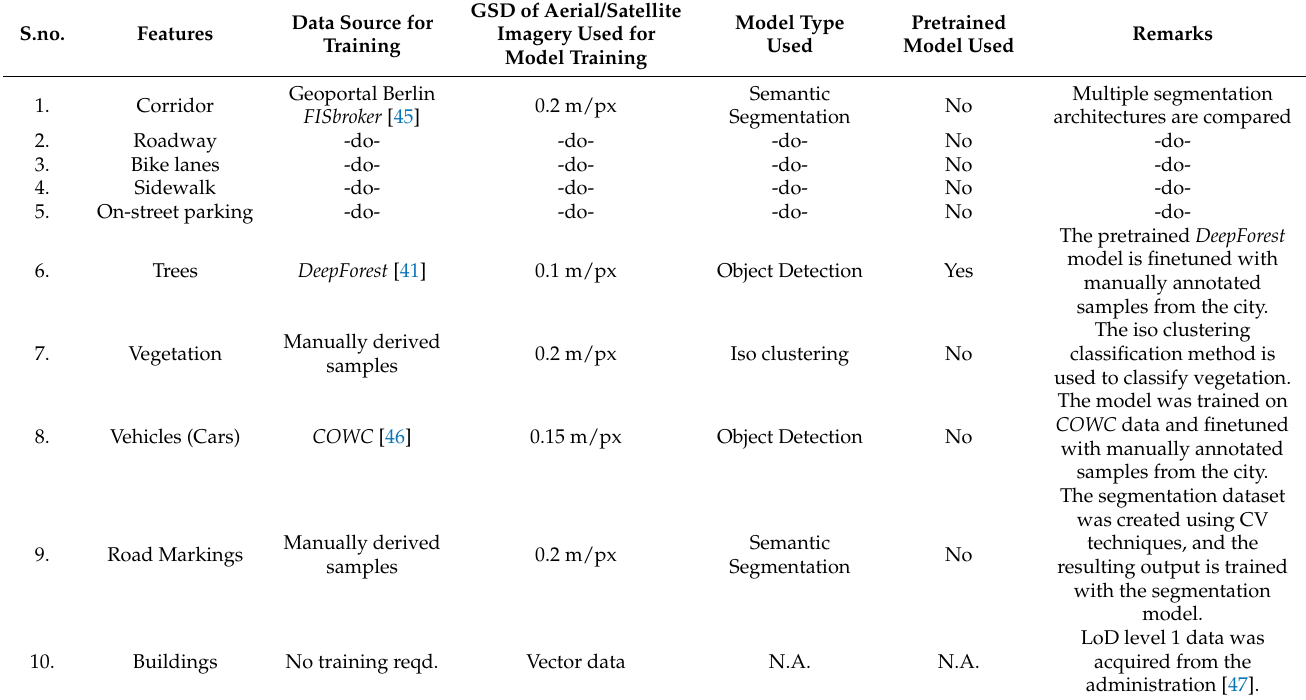
Table 1. Selected streetscape features and data sources used to acquire imagery and models.